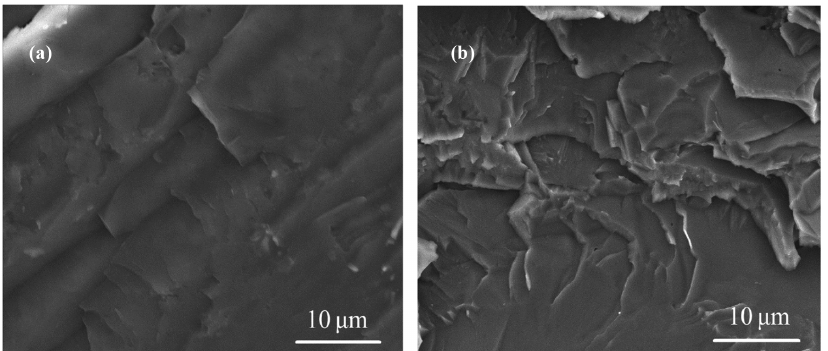
Figure 7: Shear fractographs of the joints bonded at 748K with 80 min (a) Al matrix side; (b) Mg matrix side.